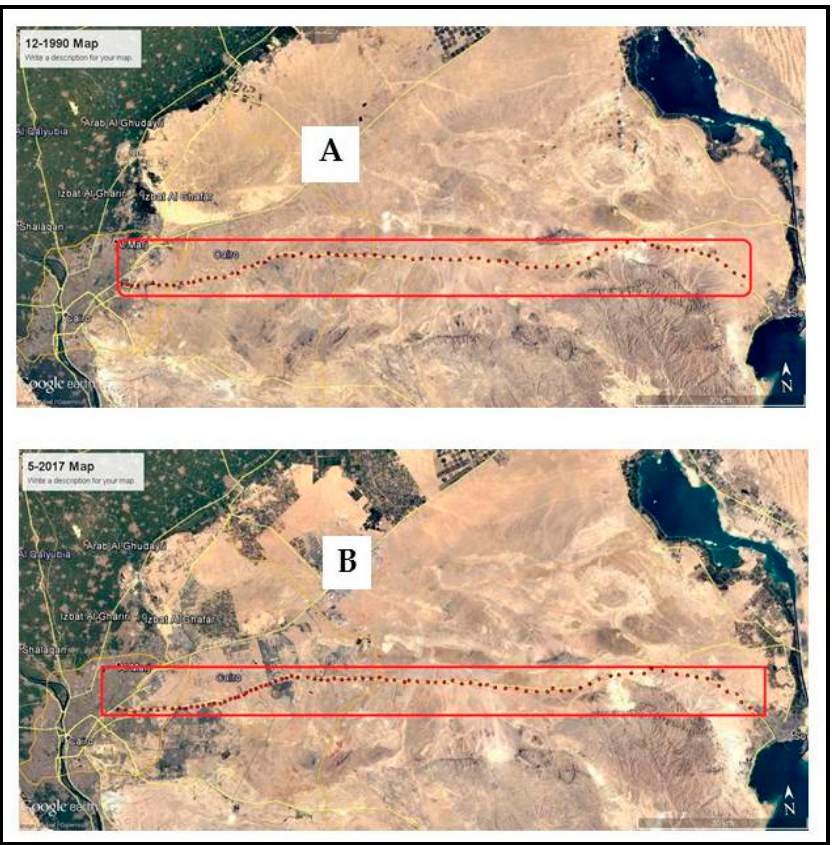
Figure 6. Satellite images of the Cairo-Suez desert road comparing occupations along its sides in 1990 ( A ) and in 2017 ( B ) due to various human activities, especially urban sprawl.